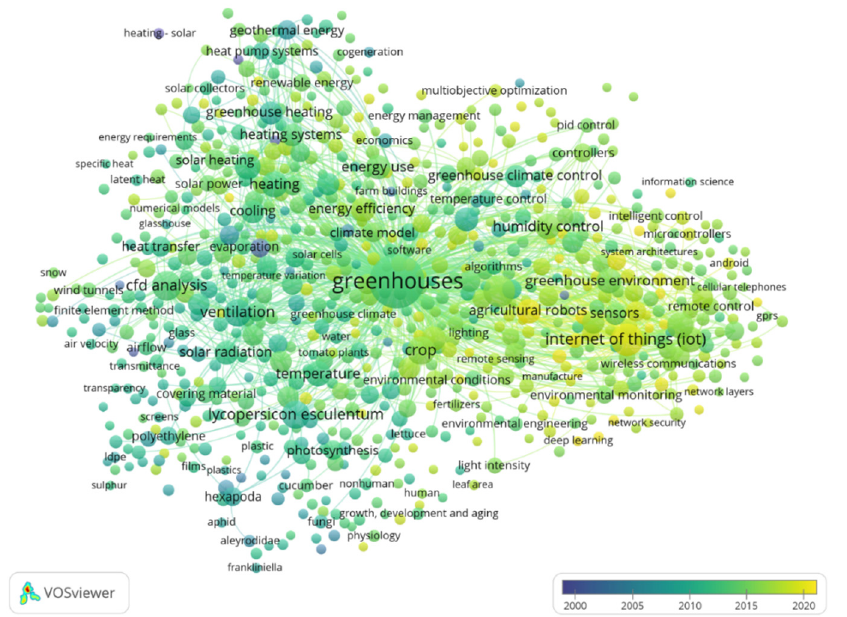
Figure 8. Keywords year map based on the greenhouse engineering publications (the blue, green and yellow colors represent earlier, recent, and most recent terms, respectively).